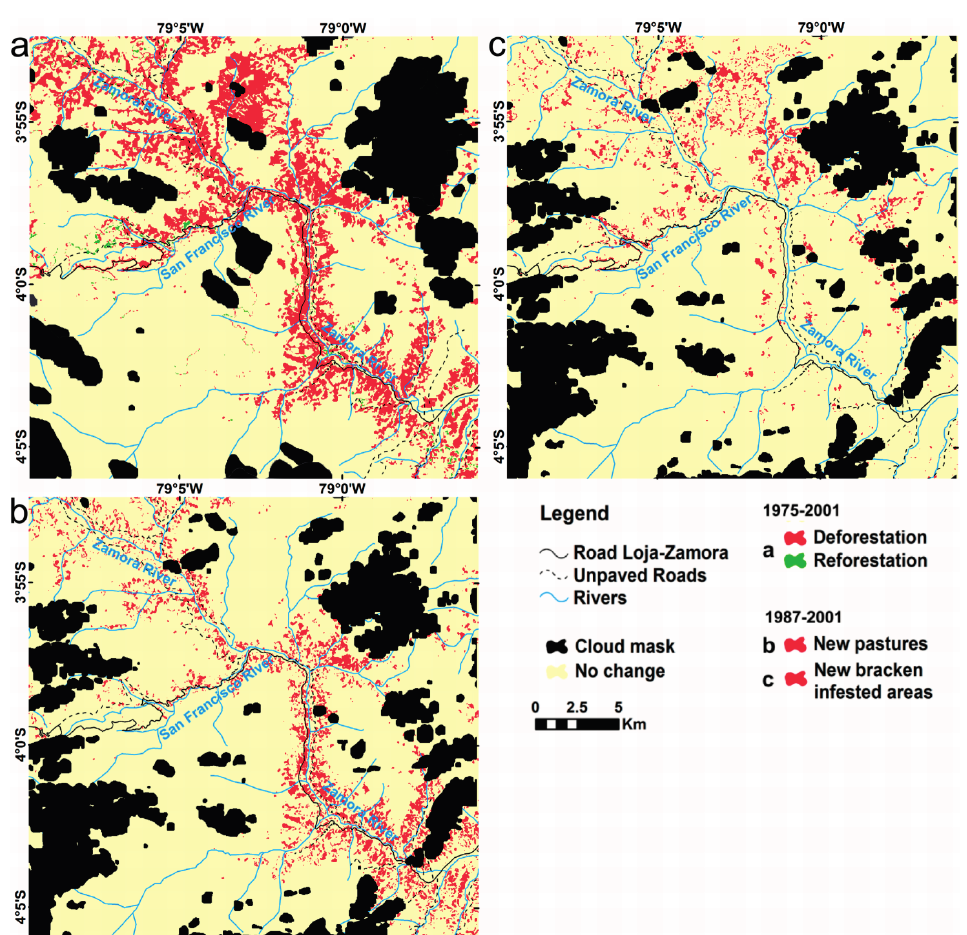
Figure 10. ( a ) Change in forest cover between 1975 and 2001; and ( b ) new pasture and ( c ) bracken-infested areas in the period